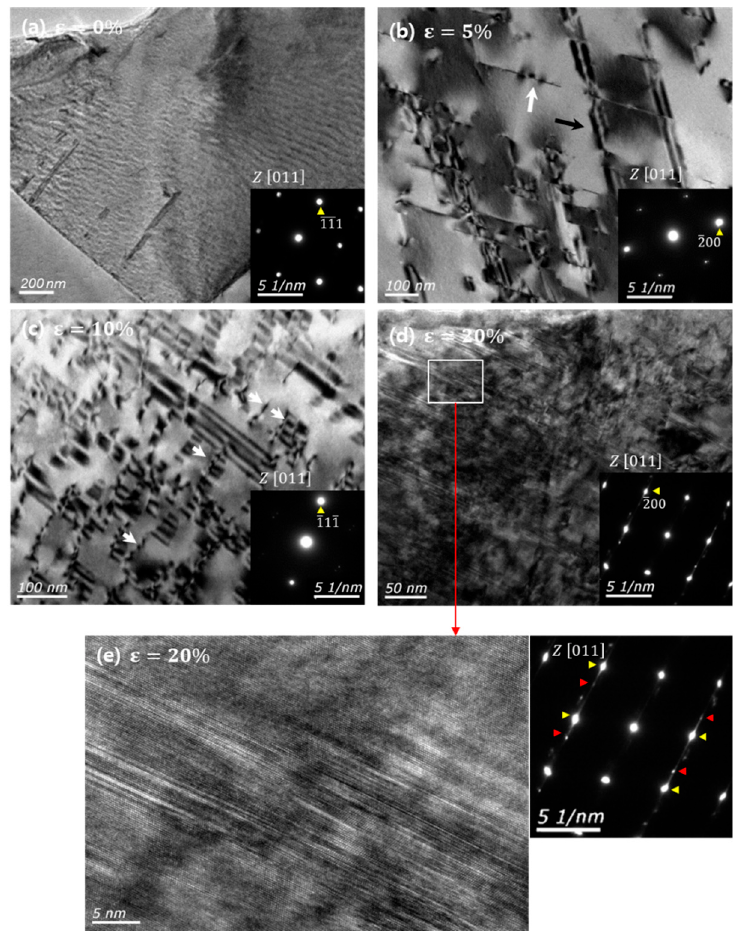
Figure 6. TEM BF images and the corresponding SAD patterns of LDX-2101 steel austenite grains: ( a ) ε =0, ( b ) ε =5%, ( c ) ε =10%, ( d , e ) ε =20% tensile strained specimen.